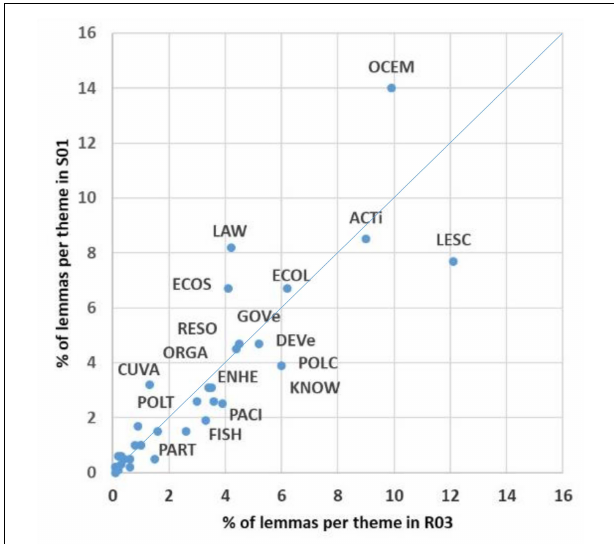
FIGURE 10 | Percentage of lemmas dedicated to each theme in the Framework for a Pacific Oceanscape (RO3; x-axis) and National Ocean Policy (S01; y-axis). Equal percentage of lemmas about the same theme in R03 and S01 align to the diagonal line of parity. The themes above the diagonal are more developed in S01, whereas those below are more developed in R03. Labels of themes below 2% limit on both axes are not given for the readability of the